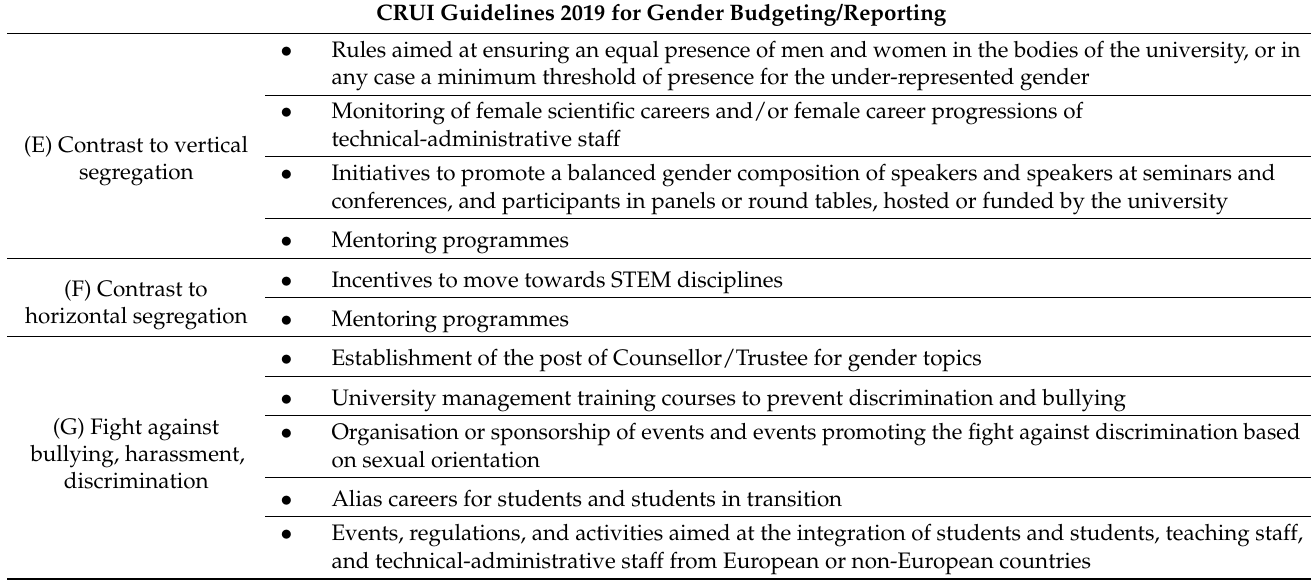
Table 2. Cont. CRUI Guidelines 2019 for Gender Budgeting/Reporting